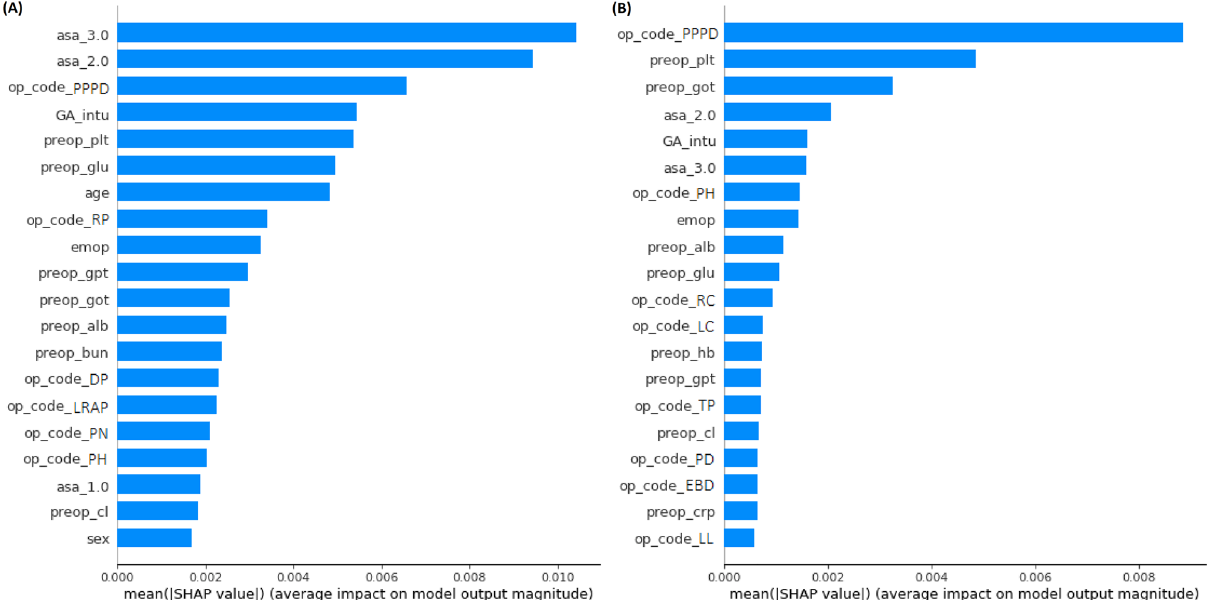
Figure 2. Feature importance of the DNN model for preoperative prediction for the necessity of invasive catheter insertion via SHAP assessment. ( A ) Feature importance of the DNN model for the preoperative prediction of the need for an arterial catheter insertion ( B ) Feature importance of the DNN model for the preoperative prediction of the need for a central venous catheter insertion. SHAP, SHapley Additive exPlanation; DNN, deep neural network; PPPD, pylorus preserving pancreaticoduodenectomy; GA_intu, general anesthesia with endotracheal intubation; plt, platelet; glu, glucose; RP, radical prostatectomy; emop, emergency operation; gpt, glutamate pyruvate transaminase; got, glutamate oxaloacetate transaminase; alb, albumin; bun, blood urea nitrogen; DP, distal pancreatectomy; LRAP, laparoscopic robotic assisted procedure; PN, partial nephrectomy; PH, partial hepatectomy; cl, chloride; RC, radical cystectomy; LC, laparoscopic cholecystectomy; hb, hemoglobin; TP, total pancreatectomy; PD, pancreaticoduodenectomy; EBD, excision of other bile duct; crp, c-reactive protein; LL, lobectomy of liver.